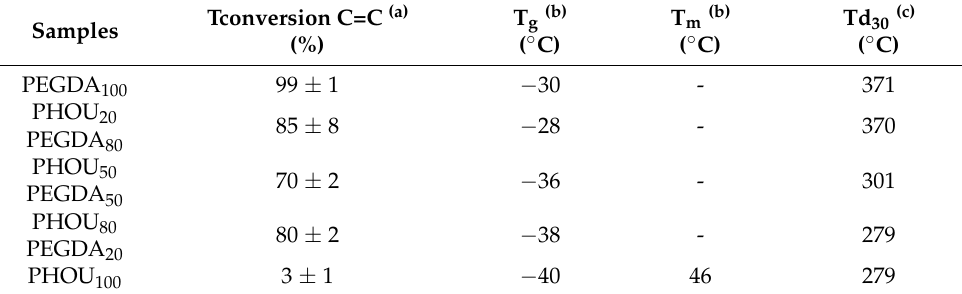
Table 2. Characteristics of the networks.